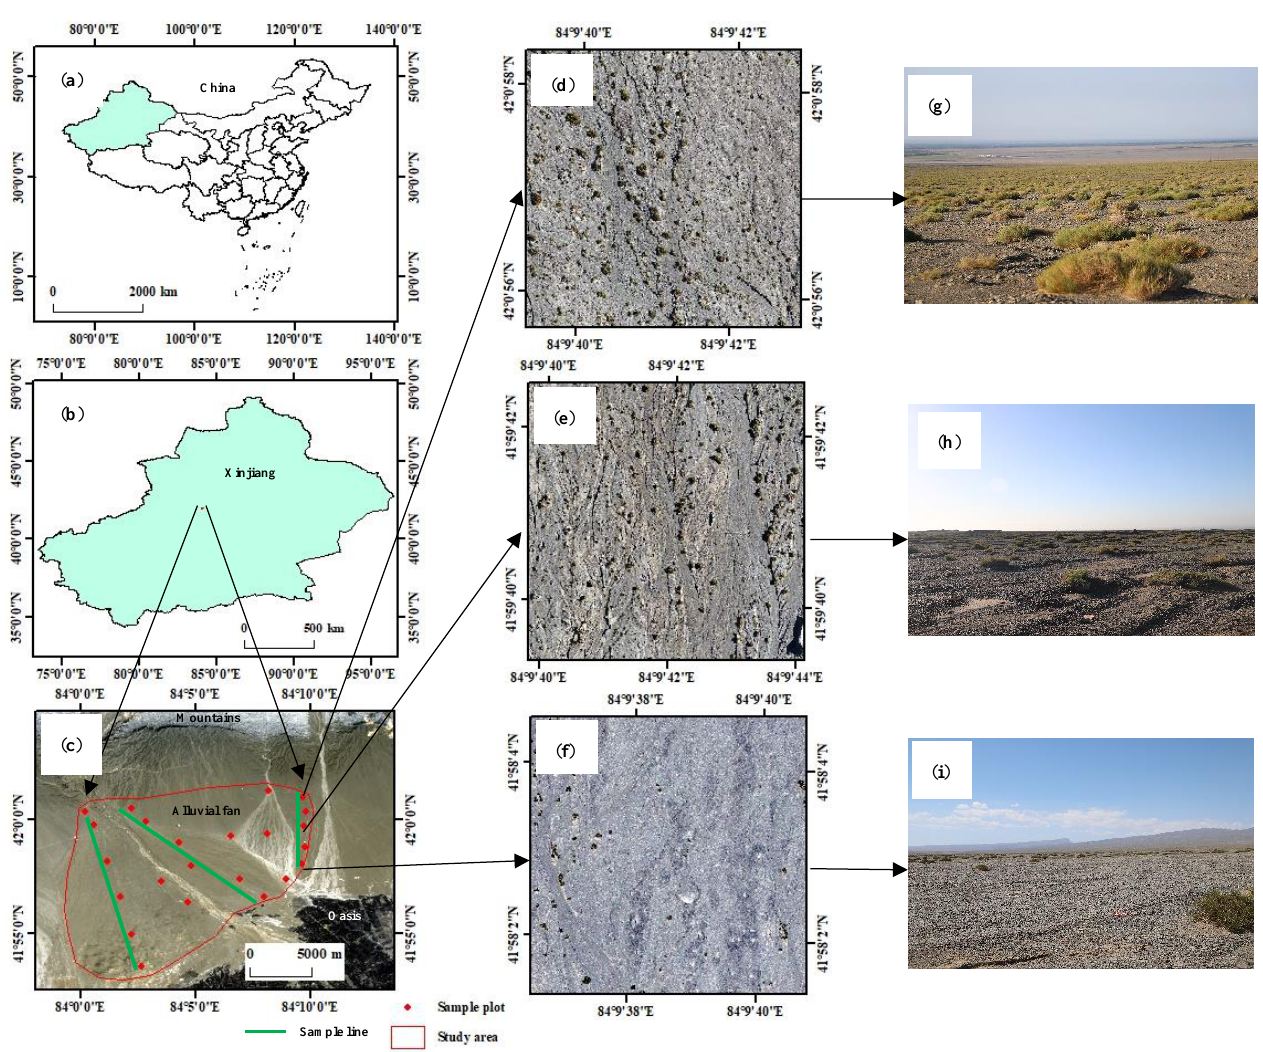
Figure 1. Study sites location: ( a ) map of study area in the Xinjiang Autonomous Region of China; ( b ) map of study area in Gobi Desert in the Xinjiang Autonomous Region; ( c ) map of sampling area in the Gobi Desert; ( d – f ) UAV remote sensing images of top, middle and bottom of the alluvial fan, respectively; ( g – i ) vegetation landscape pictures of top, middle and bottom of the alluvial fan, respectively.